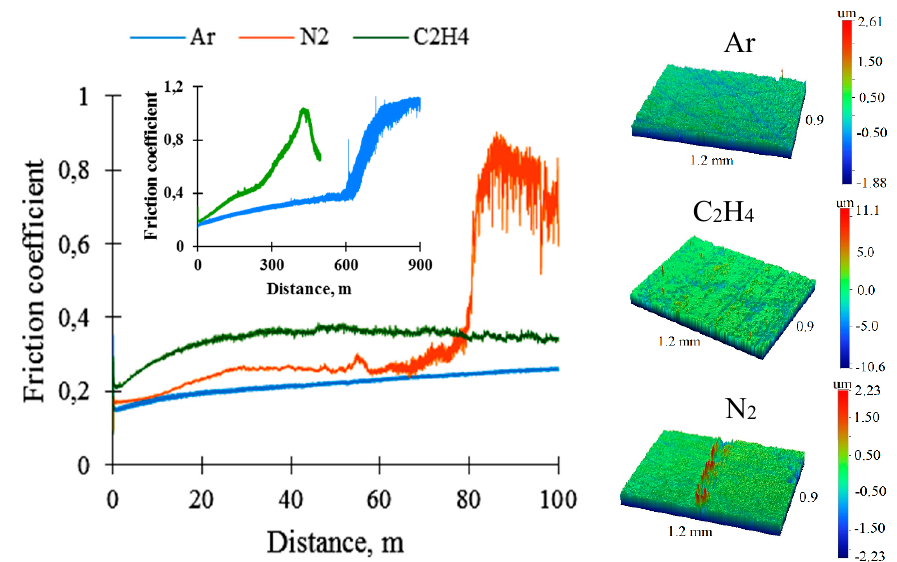
Figure 5. Dependence of the friction coefficient on the distance and 3D profiles of tribo-contact zones